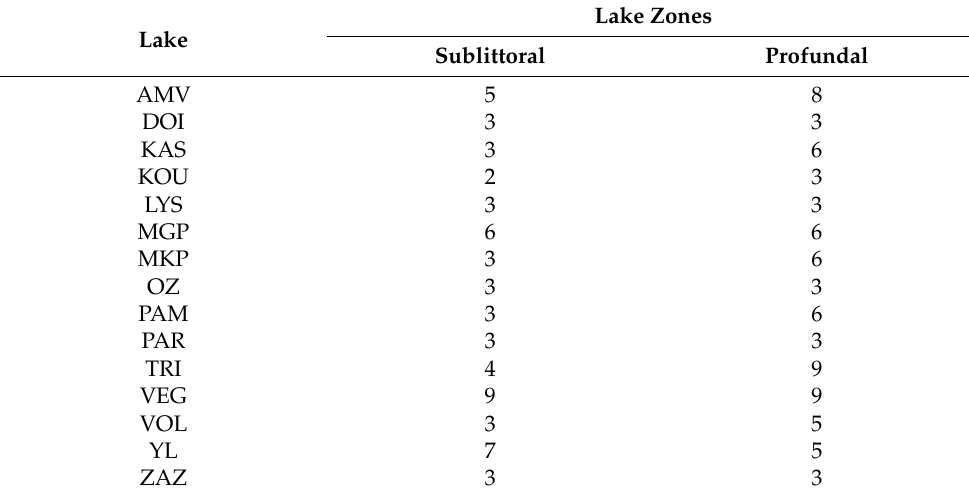
Table 2. Sampling effort (number of sites) conducted in each